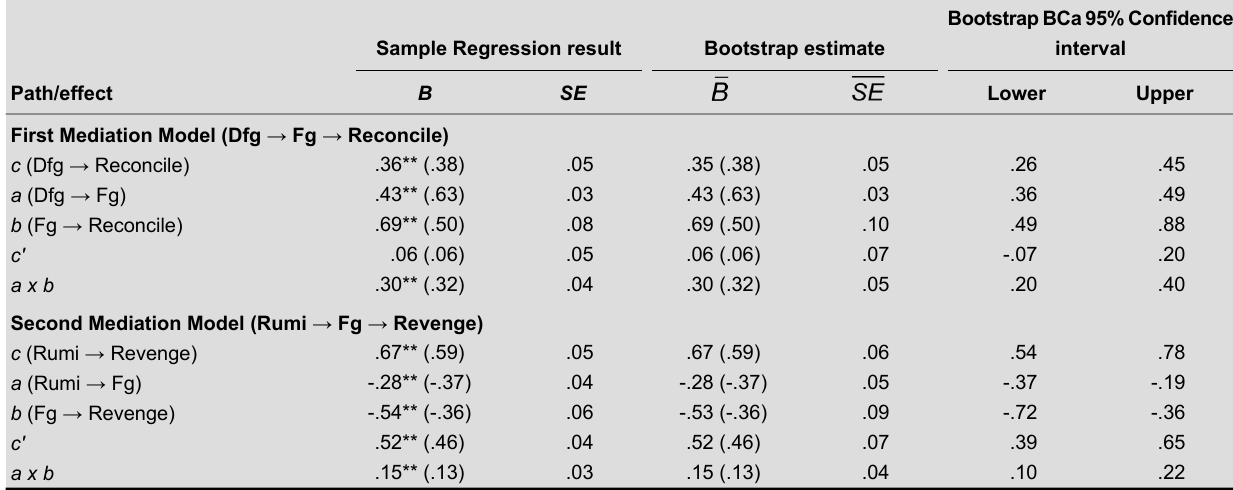
Evidence of Nomological Validity by Testing Two Mediation Models With Forgiveness as a Mediator